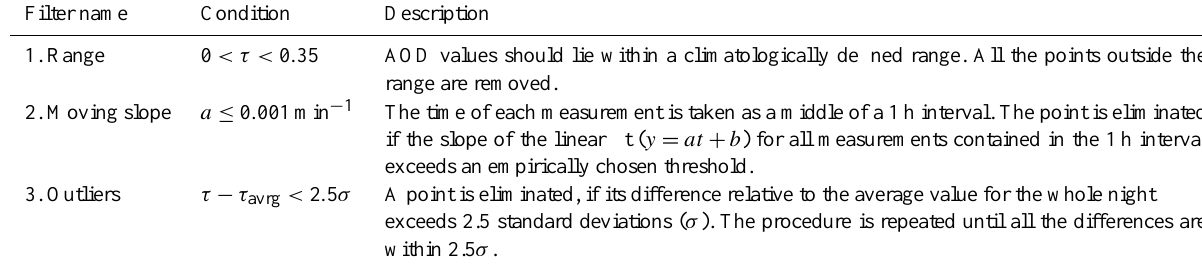
Table 3. Cloud filter protocol employed in this work. The three filters of the table are meant to be employed sequentially. Filter